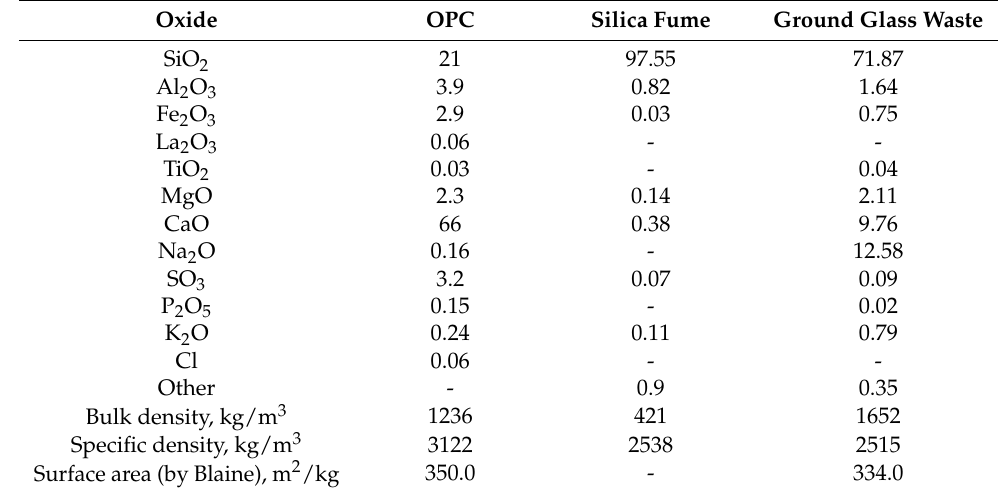
Table 2. Chemical oxide compositions and physical properties of ordinary Portland cement, silica fumes and ground glass waste, % (according to X-ray fluorescence (XRF)